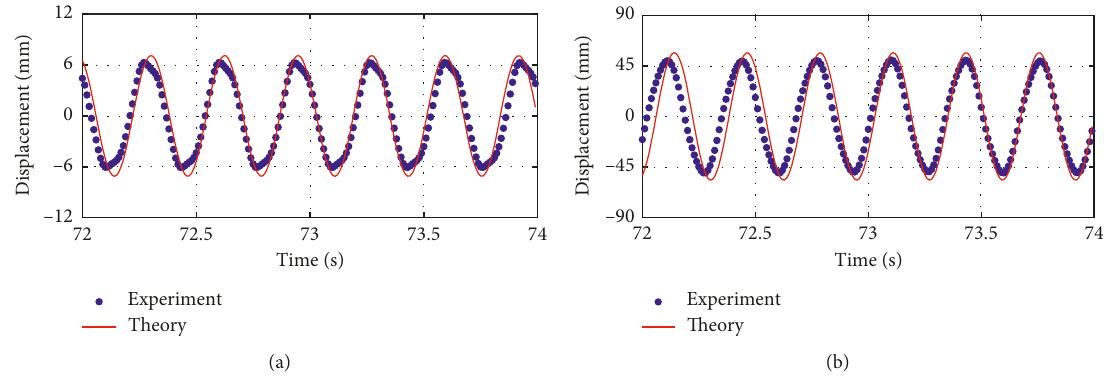
Figure 5: Displacements of the cable under the first modal vibration with the NSD: (a) damper location; (b)